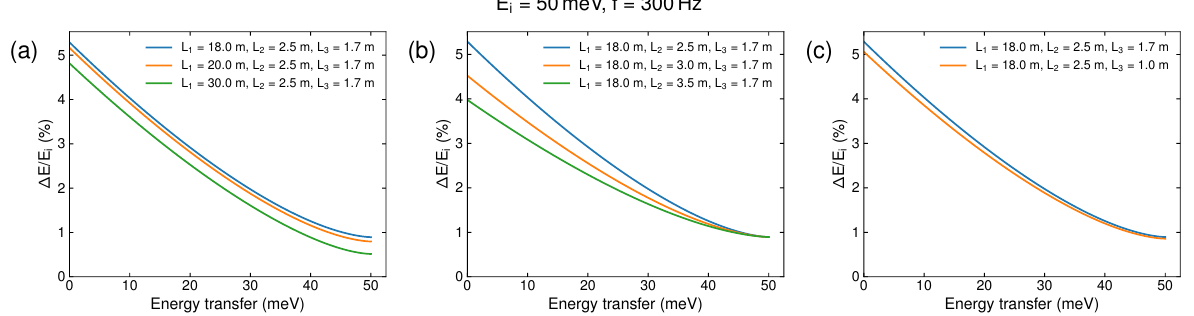
Figure 9. Calculated energy resolutions as a function of energy transfer for several sets of flight paths. E i , f , and the sample diameter are 50meV, 300Hz, and 20mm, respectively. (a) The case varying L 1 as 18m, 20m, and 30m with L 2 and L 3 being fixed at 2.5m and 1.7m, respectively. (b) The case varying L 2 as 2.5m, 3.0m, and 3.5m with L 1 and L 3 being fixed at 18m and 1.7m, respectively. (c) The case varying L 3 as 1.7m and 1.0m with L 1 and L 2 being fixed at 18m and 2.5m,